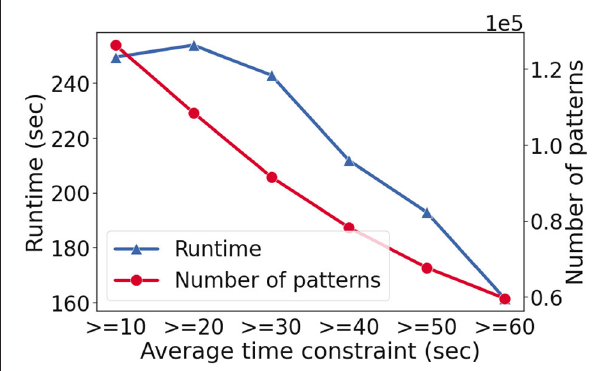
FIGURE 4 | The runtime (y-axis-left) and the number of patterns found (y-axis-right) with varying constraints (x-axis) on the fashion e-commerce dataset. In this setting, the minimum frequency threshold, θ , set to 2, to stress test runtime